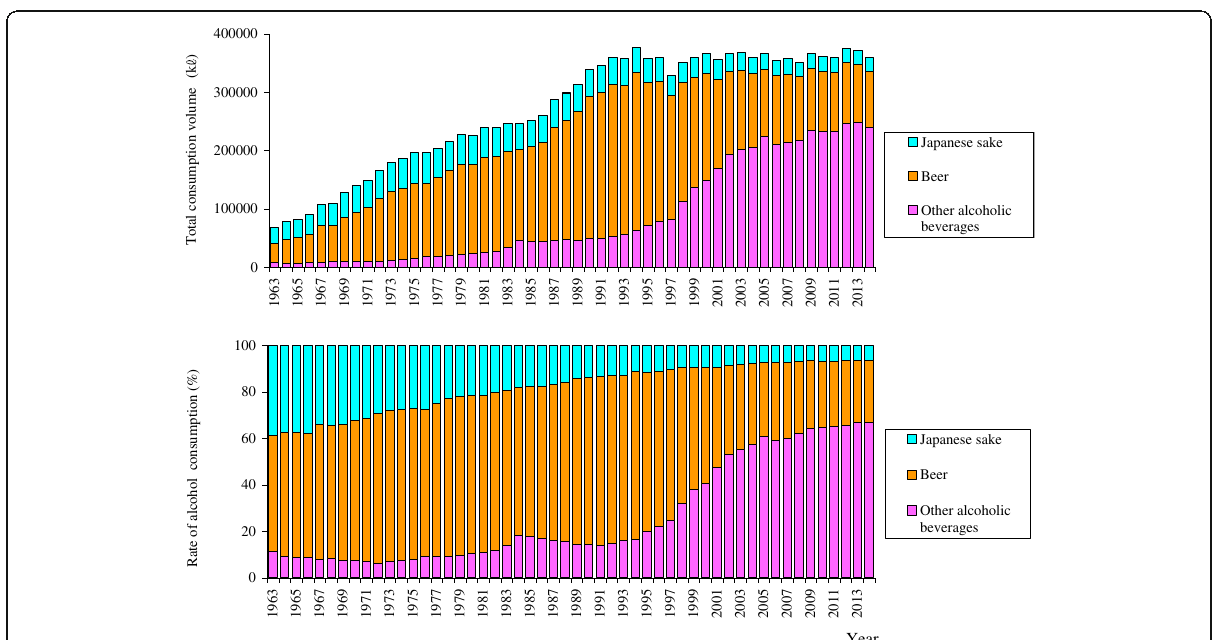
Fig. 11 Total consumption volumes and proportions of alcohol consumption in Chiba Prefecture (National Tax Agency HP